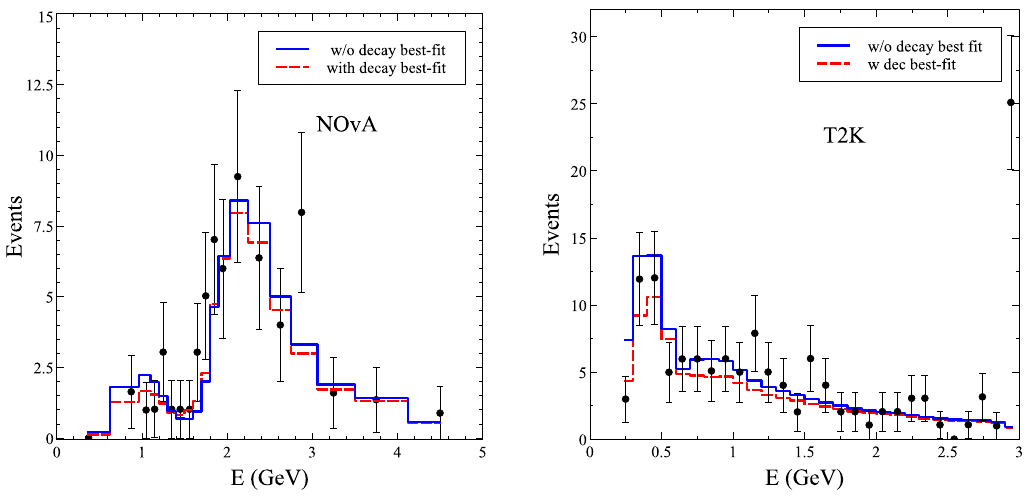
Figure 2 . Muon event spectra for NOvA and T2K. The left panel is for NOvA while the right panel is for T2K. The black dots with the error-bar are actual data points. The error bars correspond to the 1 (cid:27) statistical